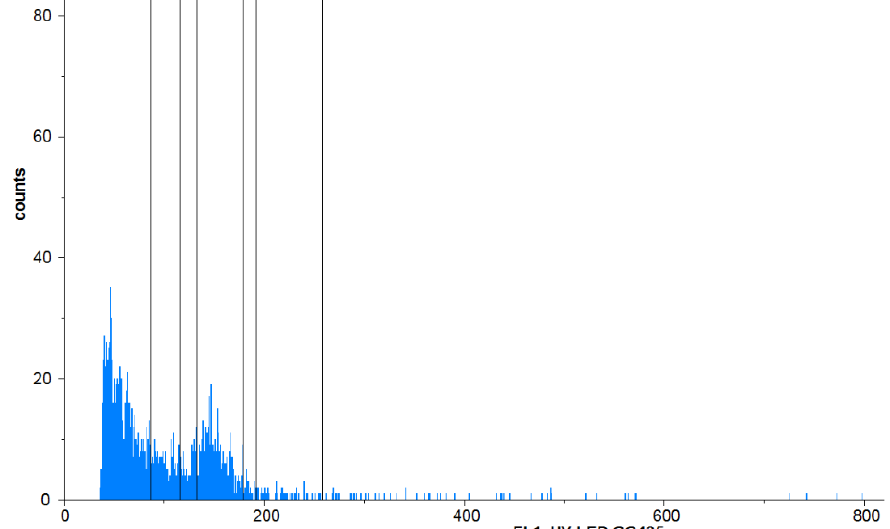
Figure 4. Argania spinosa flow cytometry profile 3, cells count represented on the Y axis while fluorescence intensity is represented on the X axis